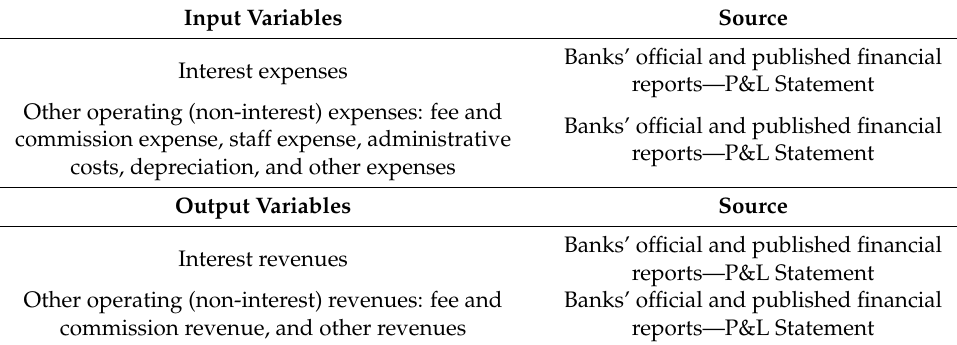
Table 1. Definition of inputs and